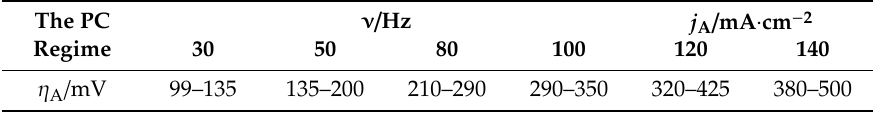
Table 6. Overpotential amplitude ( η A ) responses obtained during electrodeposition processes with the selected parameters of the PC